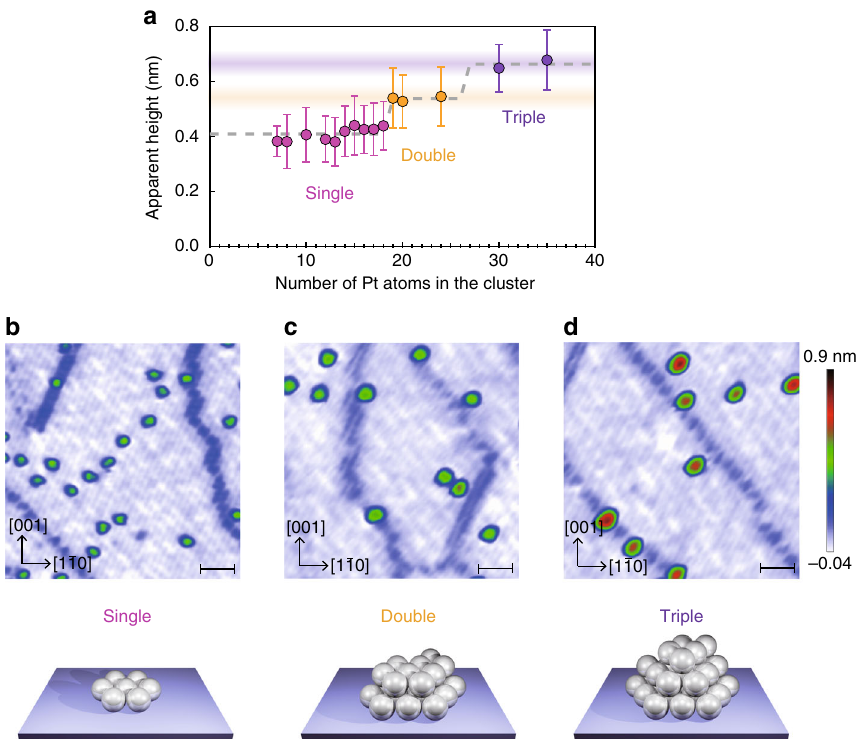
Fig. 2 Morphologies of mass-selected Pt n clusters on Al 2 O 3 . a Size dependency of average cluster height on Al 2 O 3 . The error bars and dashed lines represent the standard deviations and morphologies simulated using the modi fi ed bond-additivity model. Source data are provided as a Source Data fi le. b – d Scanning tunnelling microscopy (STM) images of Pt n /Al 2 O 3 for n = 7 ( b ), n = 24 ( c ), and n = 35 ( d ) (scale bars: 5 nm). The STM measurements were performed at 78